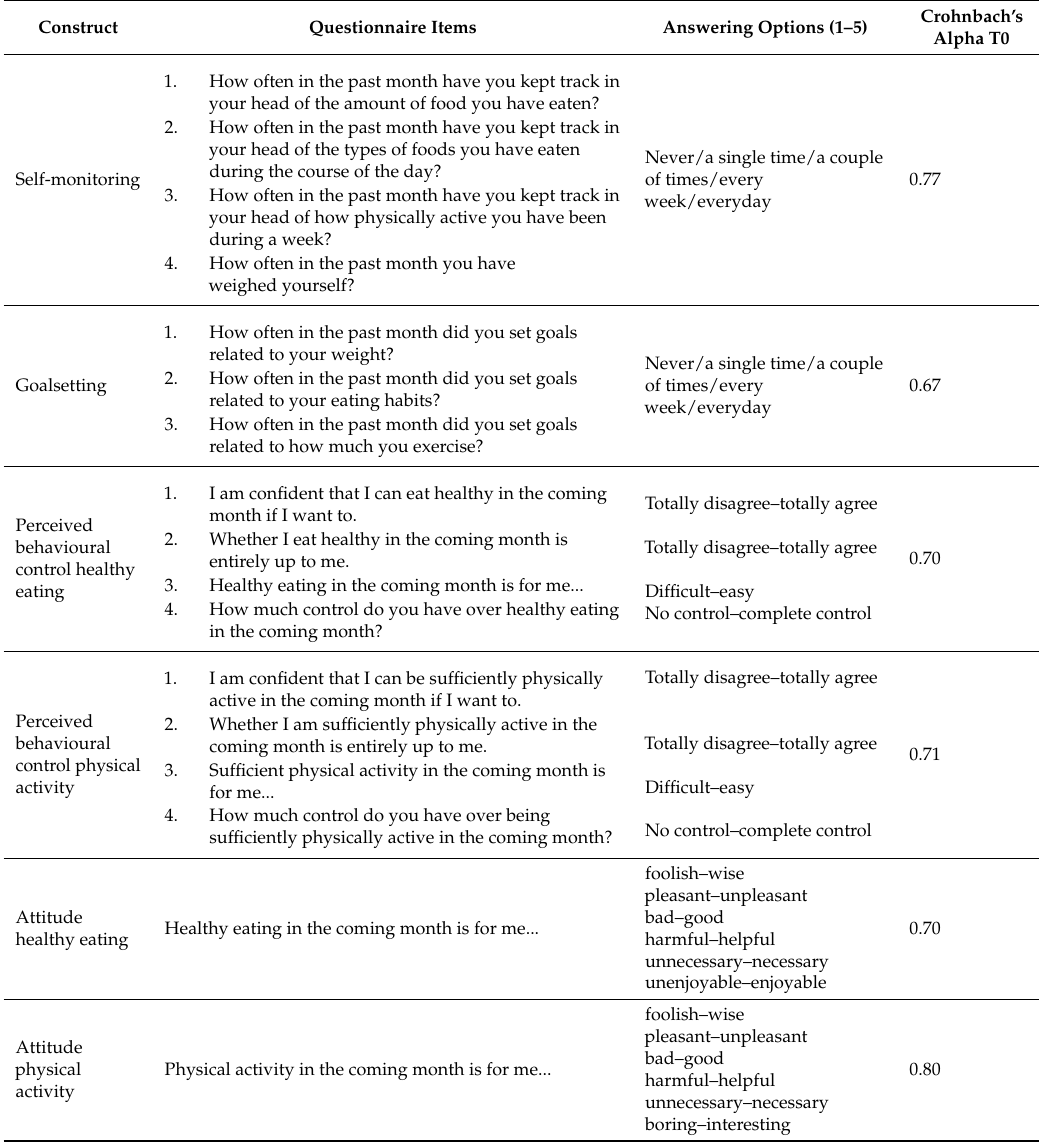
Table 1. Items to measure self-monitoring, goalsetting, perceived behavioural control, and attitude in the PhysioDom HDIM